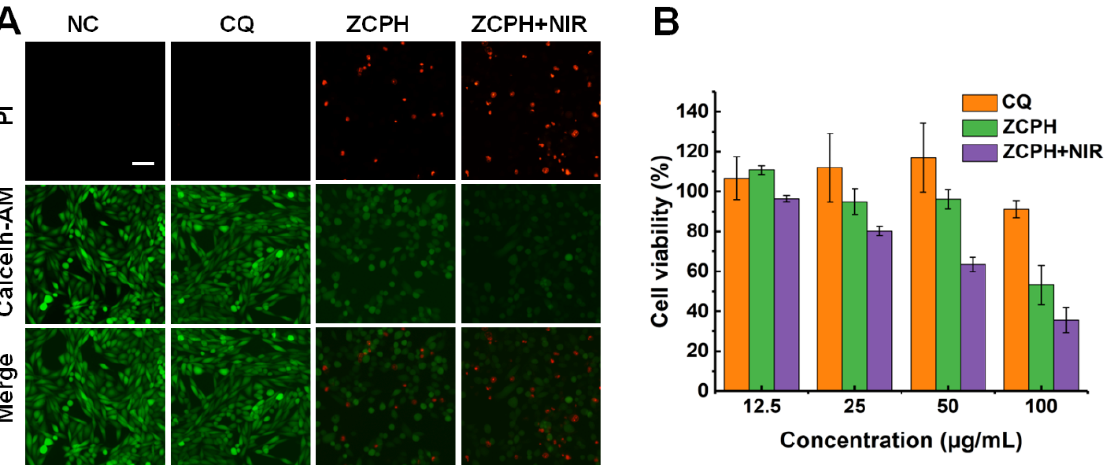
Figure 4. ( A ) The live/dead staining of SKOV3 cells with different treatments. The living cells and dead cells were stained with Calcein-AM and PI, respectively, representing green and red fluorescence. ( B ) SKOV3 cell viability after different treatment. Scale bar: 50 µm.